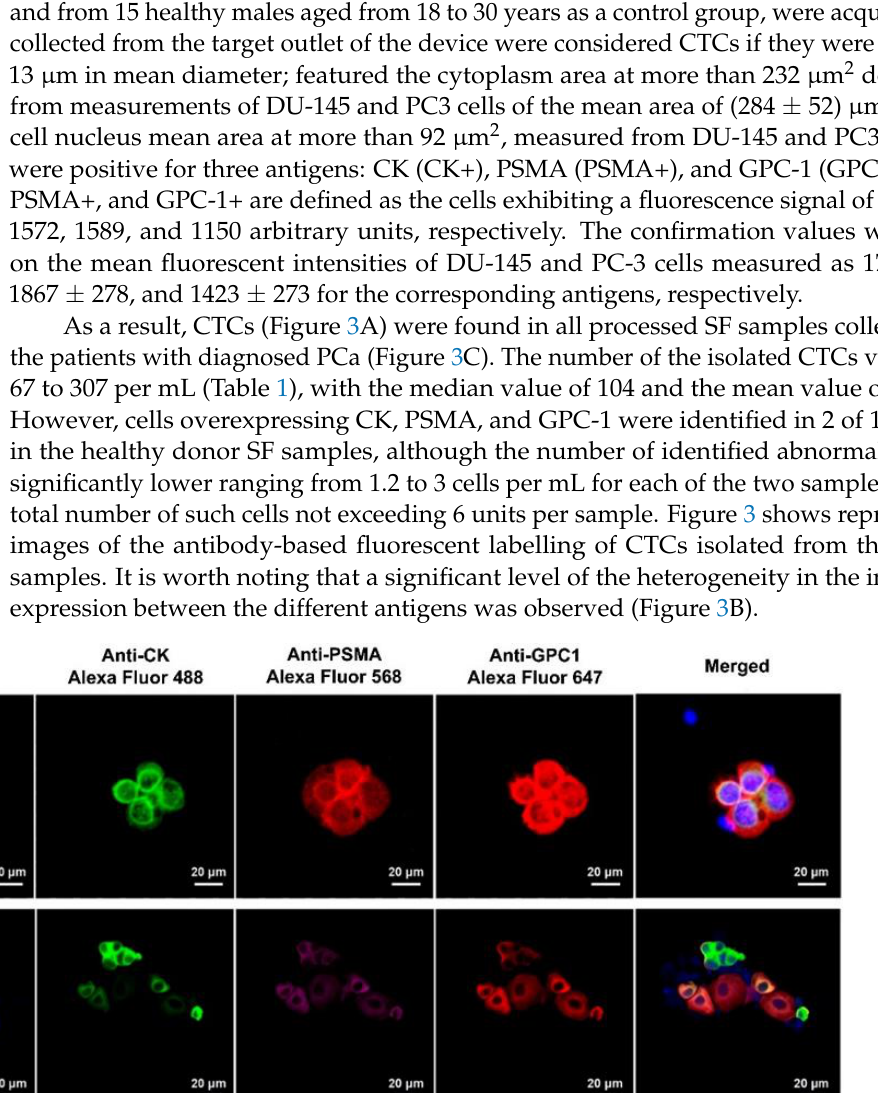
Table 1. Number of isolated CTCs from SF samples and parameters of PCa in patients.